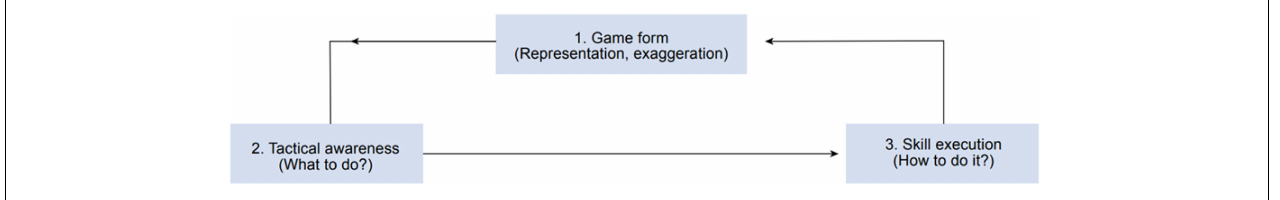
FIGURE 1 | A learning cycle according to the TGfU (Mitchell et al., 2006, p. 13).